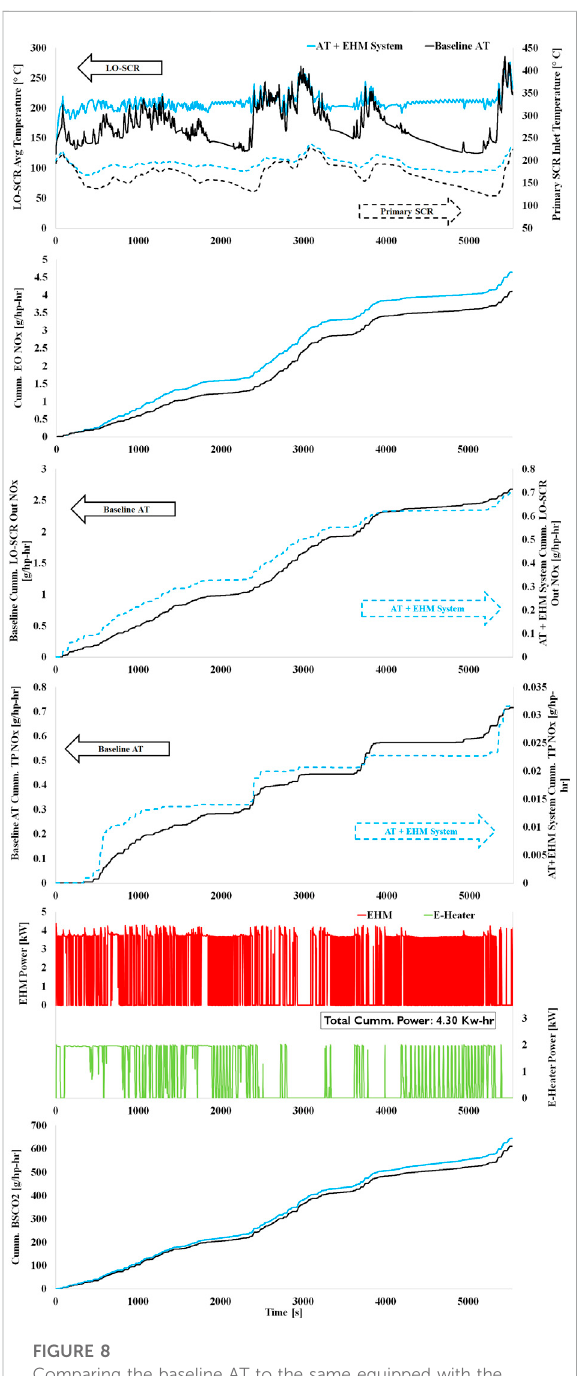
FIGURE 8 Comparing the baseline AT to the same equipped with the